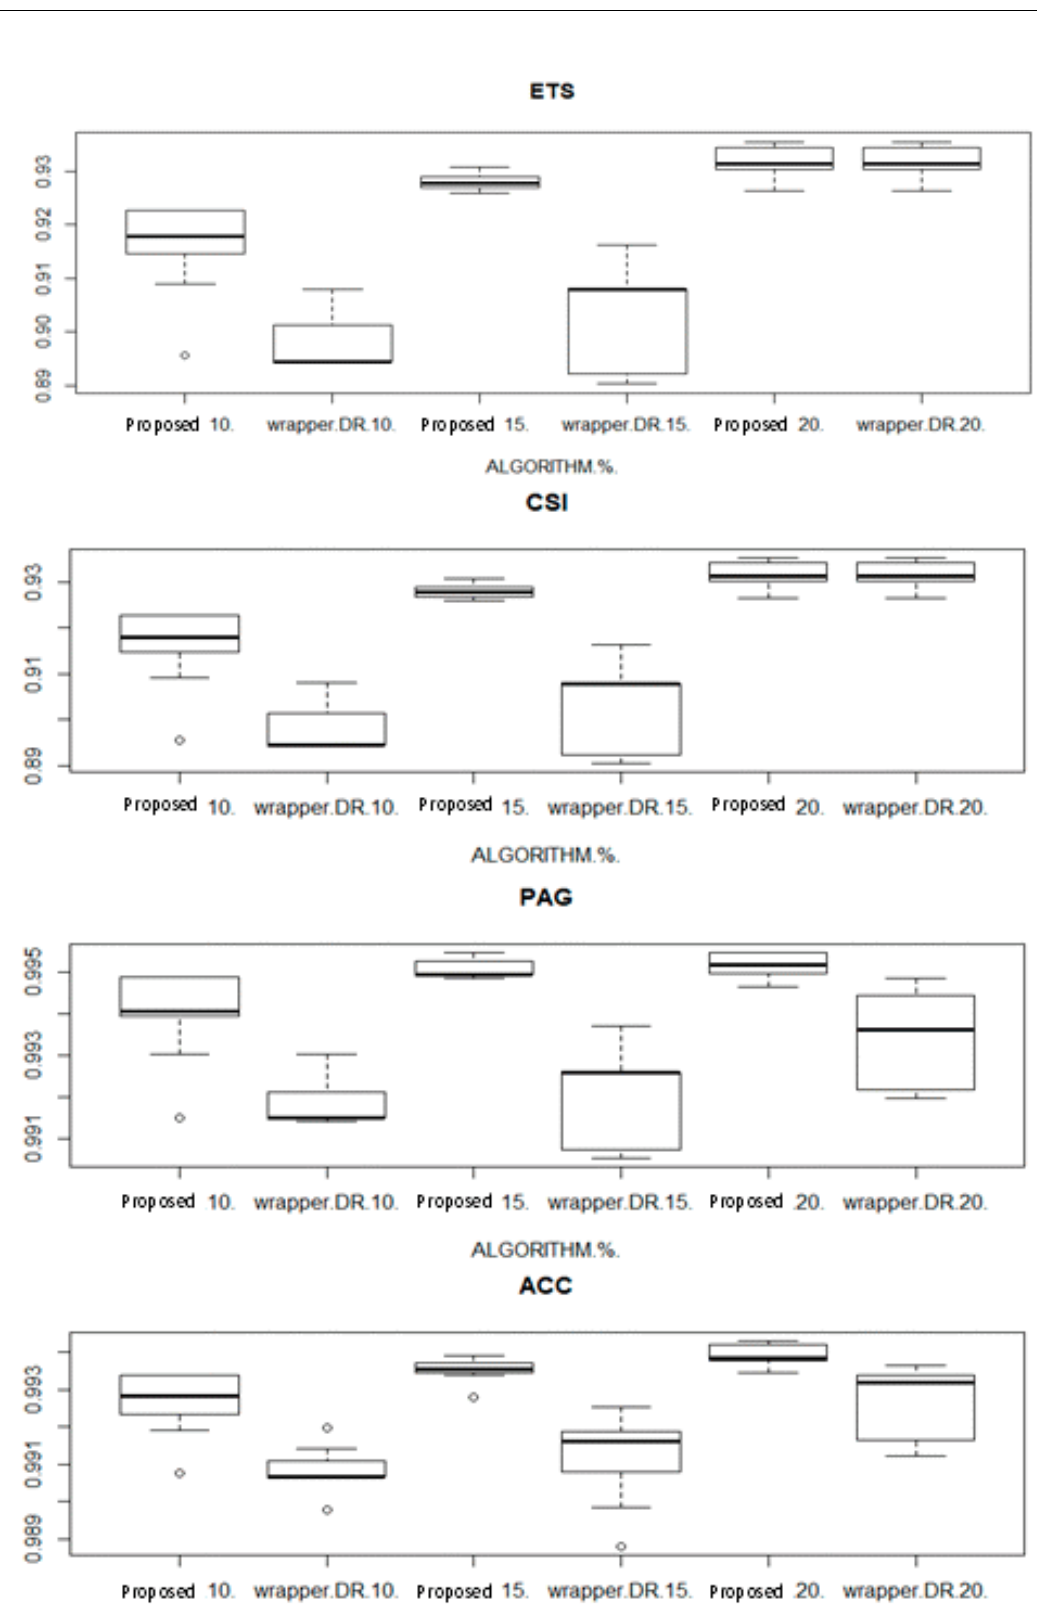
Figure 10. ETS/CSI/PAG/ACC result in binary: proposed vs wrapper-DR.